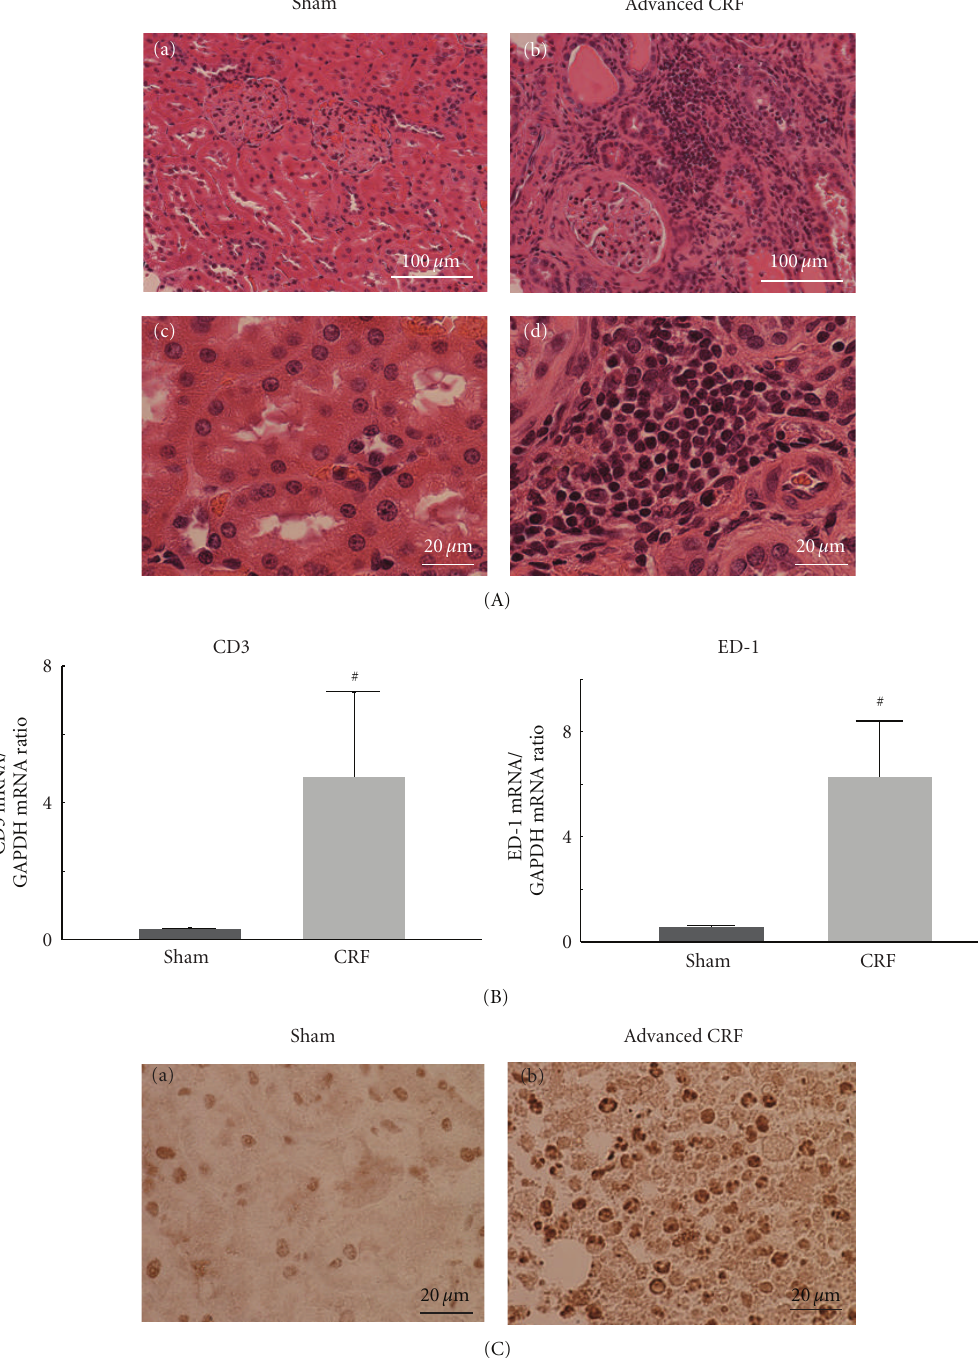
Figure 1: Histological features of sham operated (sham) and advanced CRF rat kidneys. (A) Hematoxylin and eosin staining (H&E) in sham operated (sham) and advanced CRF rat kidneys. (a) and (b) Low-power views of cortex. Magnification, × 20. (c) and (d) High-power views of cortical interstitium. Magnification, × 60. (B) The mRNA abundance of CD3 (left) and ED-1 (right) in the renal cortex of sham operated and advanced CRF (CRF) rat kidneys. # P < 0 . 05 versus sham operated rats. Values are means ± SEM ( n = 6). Di ff erences were analyzed by ANOVA followed by Dunnett’s or Student’s t -test. (C) Immunohistochemistry using antibody for Ki-67 (brown) in sham operated and advanced CRF rat kidneys. (a) and (b) High-power views of cortical interstitium. Magnification, ×